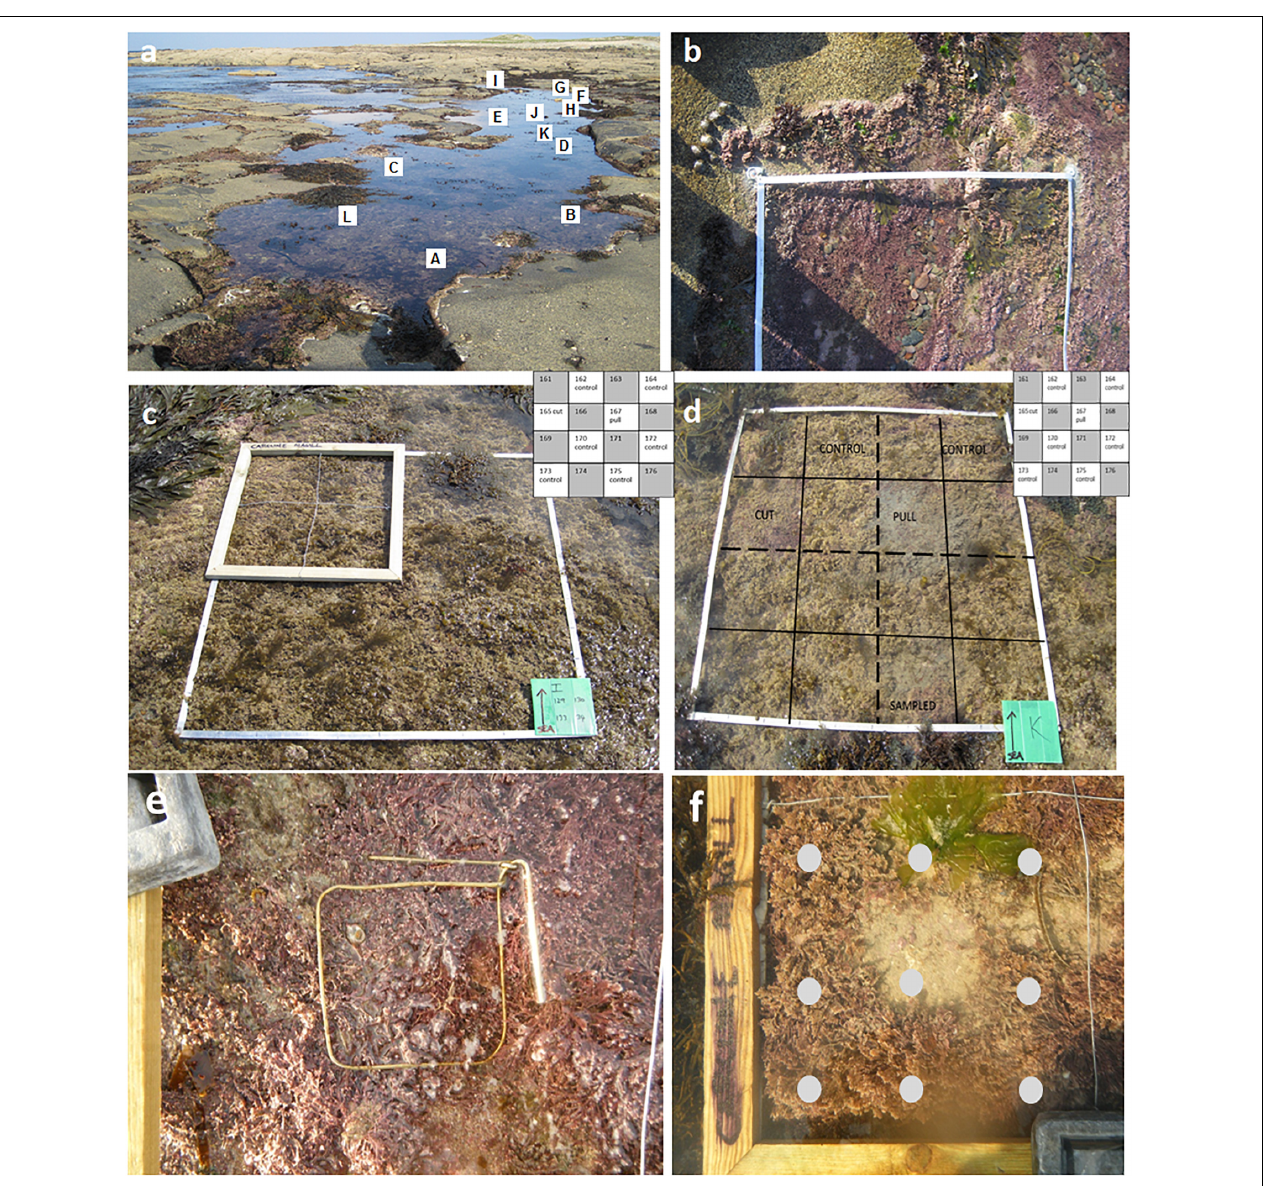
FIGURE 2 | (a) Location of sampling areas in pool. (b) Markers drilled to allow exact placement of guide quadrat. (c) Example of a harvesting grid and quadrat placement. (d) Guide quadrat after applying harvesting treatments on June 2010 [two harvesting treatments applied (cut and pull), five future control samples left untouched (top two control plots marked on picture only) and one baseline control plot sampled]. (e) Detail of 10 cm × 10 cm sampling quadrat in place. (f) Example of a plot after sampling (dots indicate approximately where depth measurements were taken in each 25 cm × 25 cm